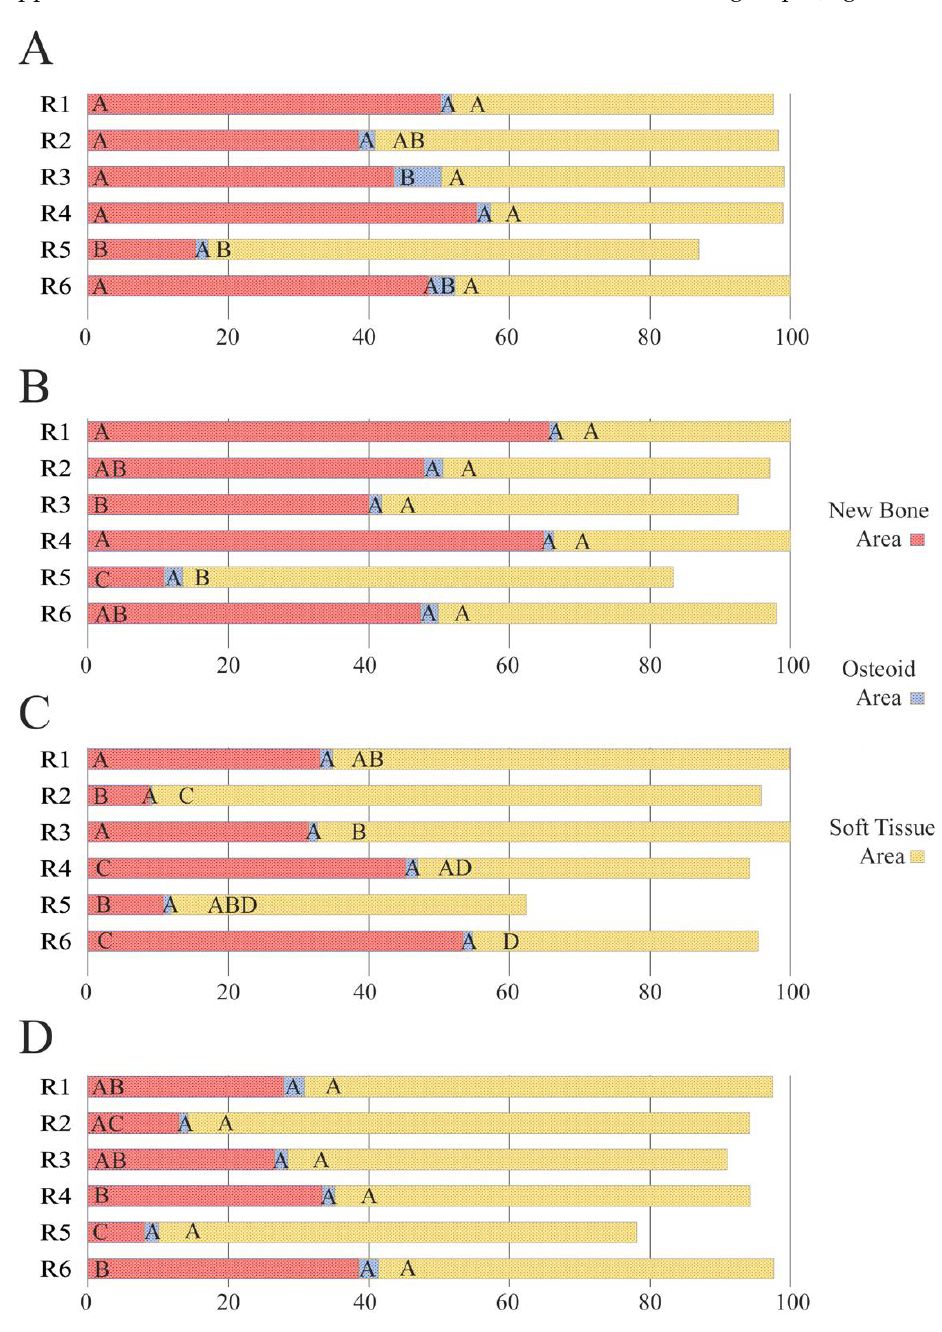
Figure 10. Histomorphometric study of the new bone area (NBA, in red), osteoid area (OA, in blue), and soft tissue area (STA, in yellow) fractions in each of the six regions of the grid. The histomor- phometry promoted in each group was assessed when the HCOO-Si-Membranes ( A ), Zn-HCOO- Si-Membranes ( B ), Dox-HCOO-Si-Membranes ( C ) and the sham groups ( D ) were analyzed. Same letters within each color indicate no significant differences.